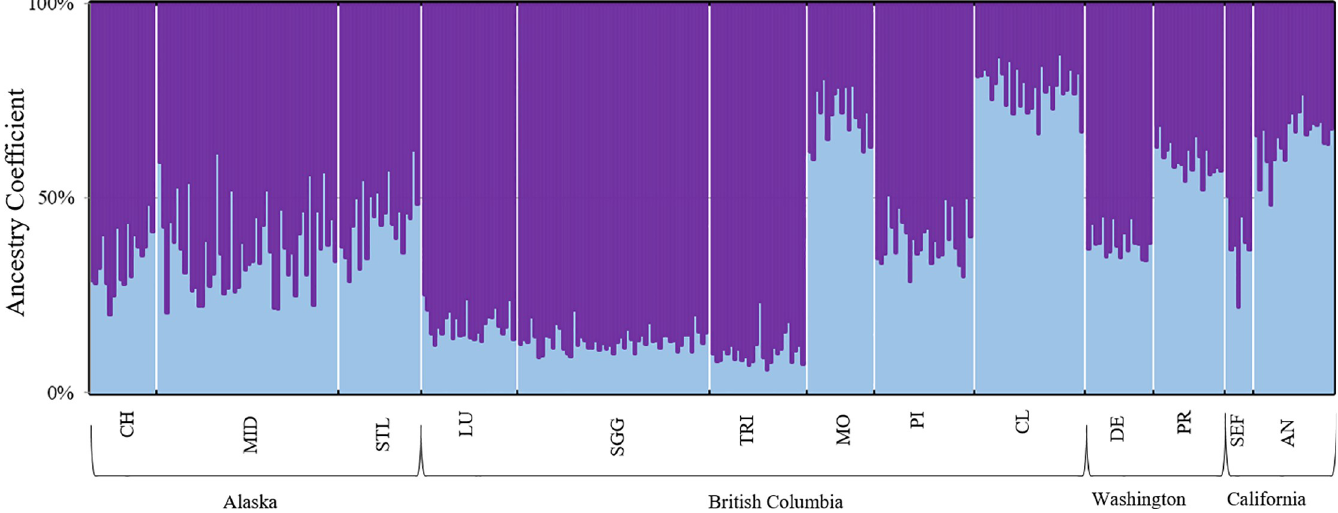
Fig 3. Hierarchical analysis of 13 eastern Pacific rhinoceros auklet colonies for ten microsatellite loci as inferred by STRUCTURE v2.3.4. Histogram plot shows ancestry coefficient (Q) on the y-axis with individuals plotted on the x-axis. Populations are listed as they move along the coastline from Alaska to California. Substructure was found for the 13 eastern breeding colonies, and supported by mean (ln Pr(X|K)) value and delta K ( Δ K) at K = 2. Substructure includes two clusters at Q > 60%, one including Chowiet, Middleton, St. Lazaria, Lucy, S’Gang Gwaay, Triangle, Pine, Destruction, and Southeast Farallon (purple), and the second including Moore, Cleland, Protection, and A ñ o Nuevo (light blue). No additional substructure was found among either the western or eastern breeding groups.